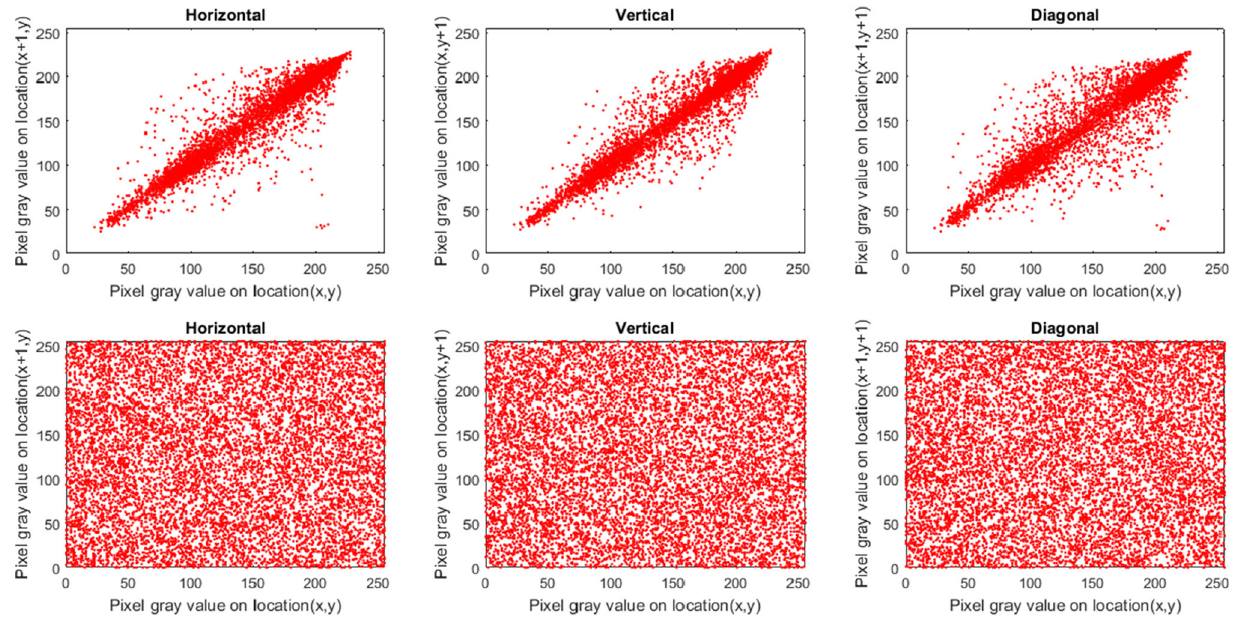
Fig.4 Correlation distributions for red component of Og01 image, in where the top row represents the distributions for the red component of Og01 image, while the bottom row displays the distributions for the red component of Cg01 image